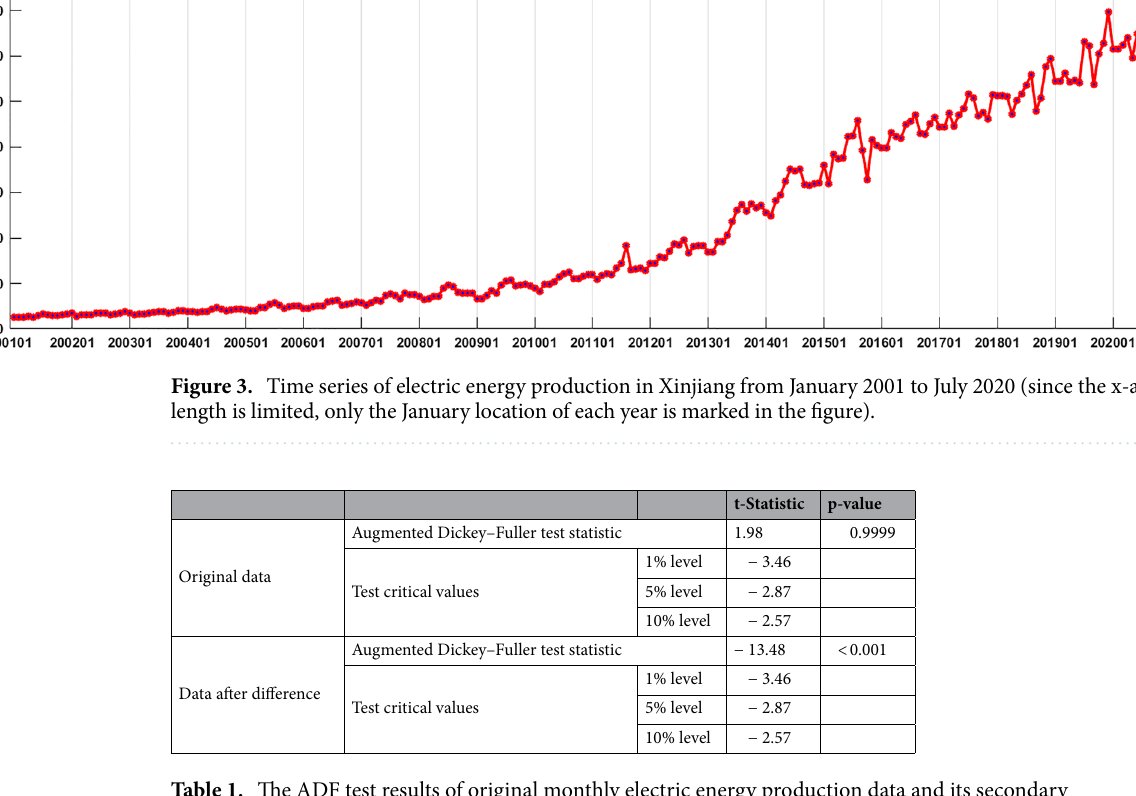
Table 1. The ADF test results of original monthly electric energy production data and its secondary differential data in Xinjiang.